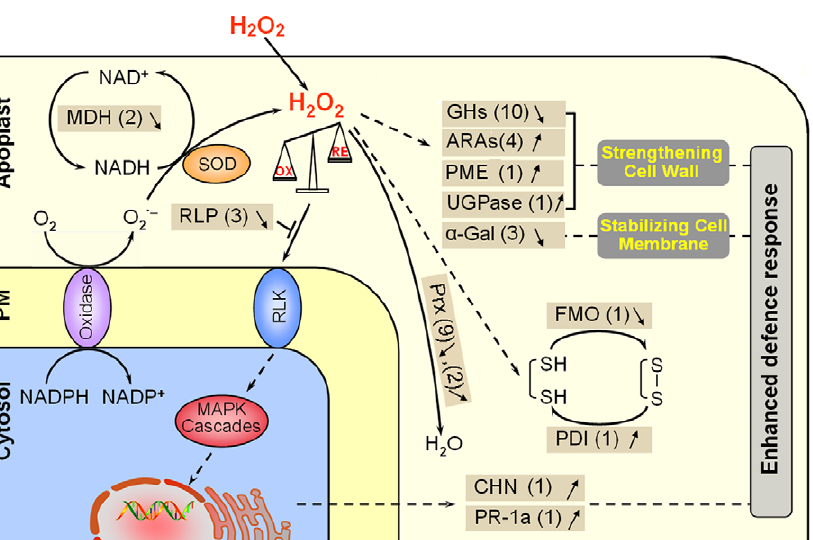
Figure 6. A putative network of H 2 O 2 -responsive apoplast proteins in rice seedling roots. The H 2 O 2 -responsive proteins identified in this study are listed in brown boxes. The up-regulated proteins are marked by q , and the down-regulated proteins are marked by Q . The number represents the number of protein spots identified. SOD, superoxidase dismutase; FMO, flavin-containing monooxygenases; PDI, protein disulfide- isomerase; Prx, peroxidase; MDH, malate dehydrogenase; GH, glycosylhydrolase; ARAs, proteins with a -L-arabinofuranosidase activity; PME, pectinesterase; UGPase, UDP-glucose pyrophosphorylase; a -GAL, a -galactosidases; RLP, receptor like protein; RLK, receptor like protein kinase; CHN, chitinase; PR-1a, PR-1 type pathogenesis-related protein; S-S, disulfide bond; SH, the reduced formation of S-S.